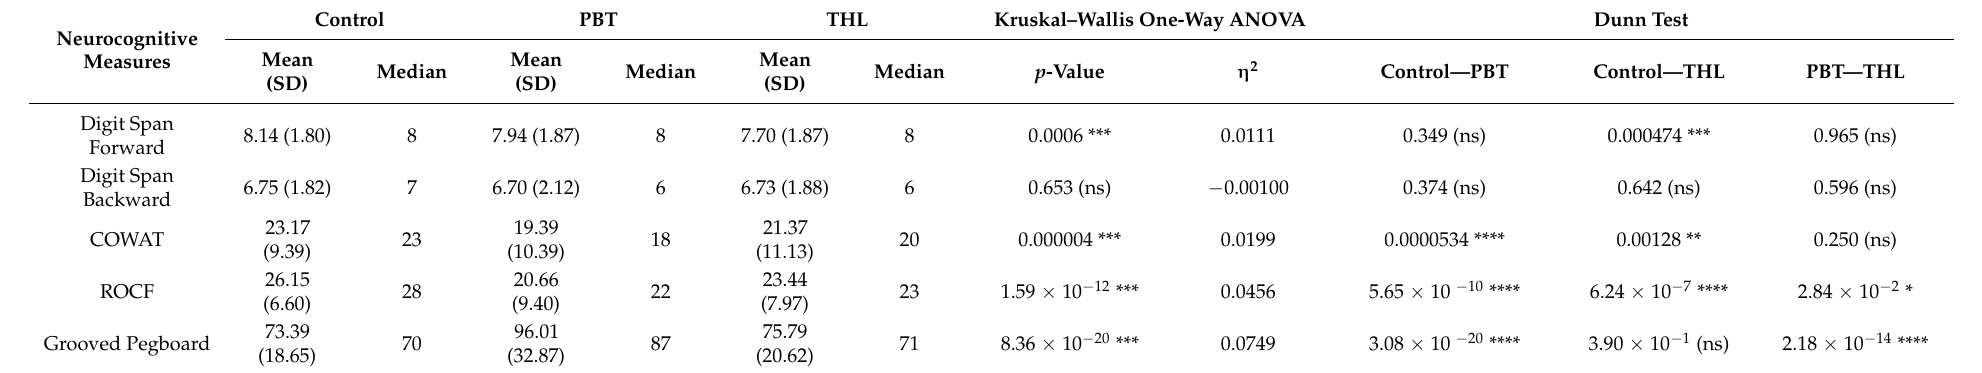
Table 2. Mean group comparisons of neurocognitive test scores among the healthy controls ( n = 646), pediatric brain tumor ( n = 137), and hematopoietic and lymphoid tissues tumor survivors ( n = 367).